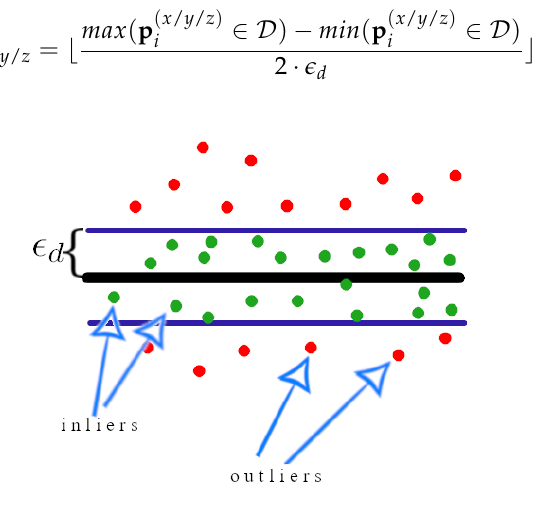
Figure 4. Inlier- plane